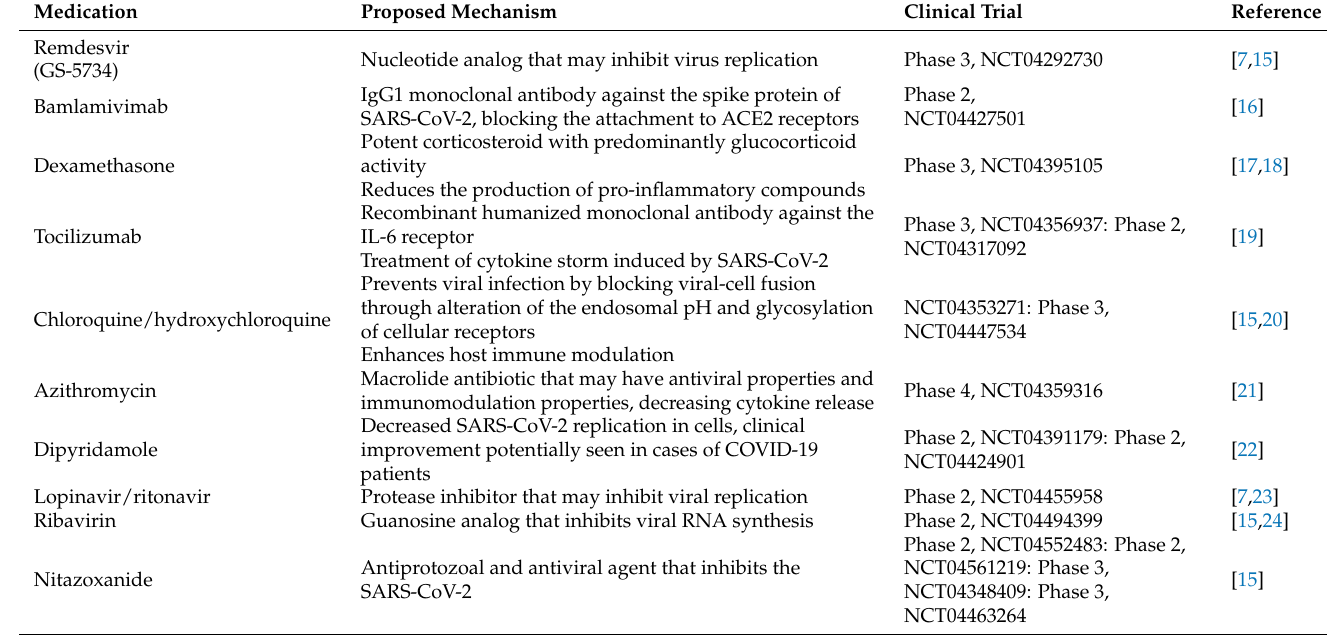
Table 1. Conventional medications are currently being evaluated for use in COVID-19